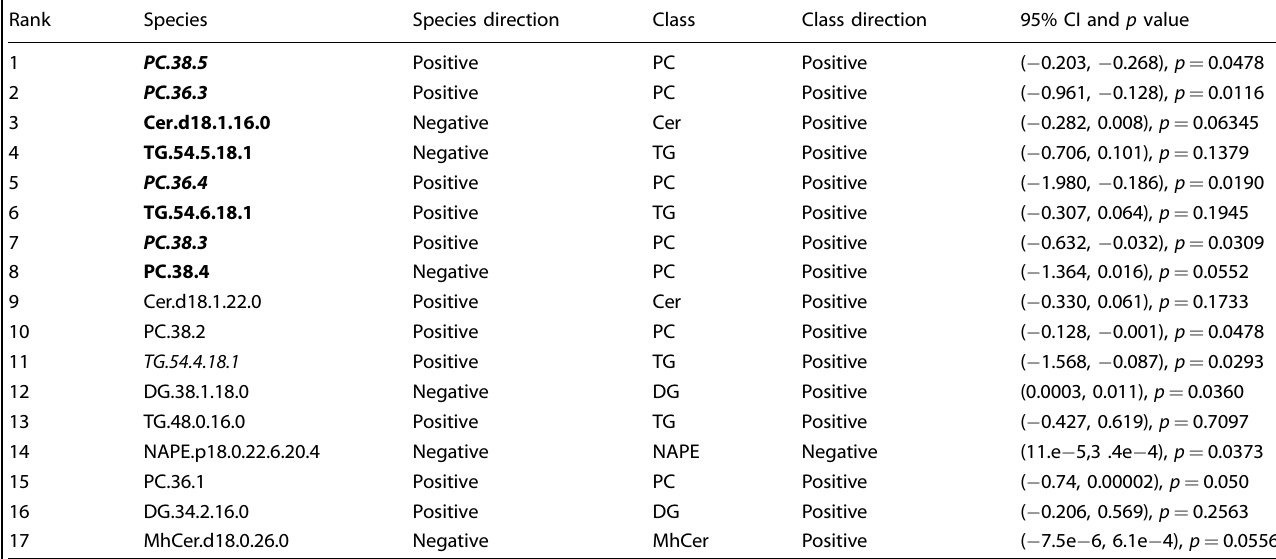
Lipid acronyms: PC glycerophosphatidylcholine, Cer ceramide, TG triradylglycerol, DG diradylglycerol, NAPE N -acylphosphatidylethanolamine, MhCer monohexosylceramide. Most contributing lipid species of the most contributing classes (Table 1) as ranked by the RF in descending order of in fl